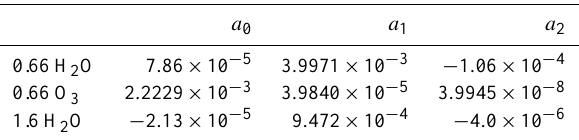
Table 1. Atmospheric correction coefficients for AATSR 0.66 and 1.6µm